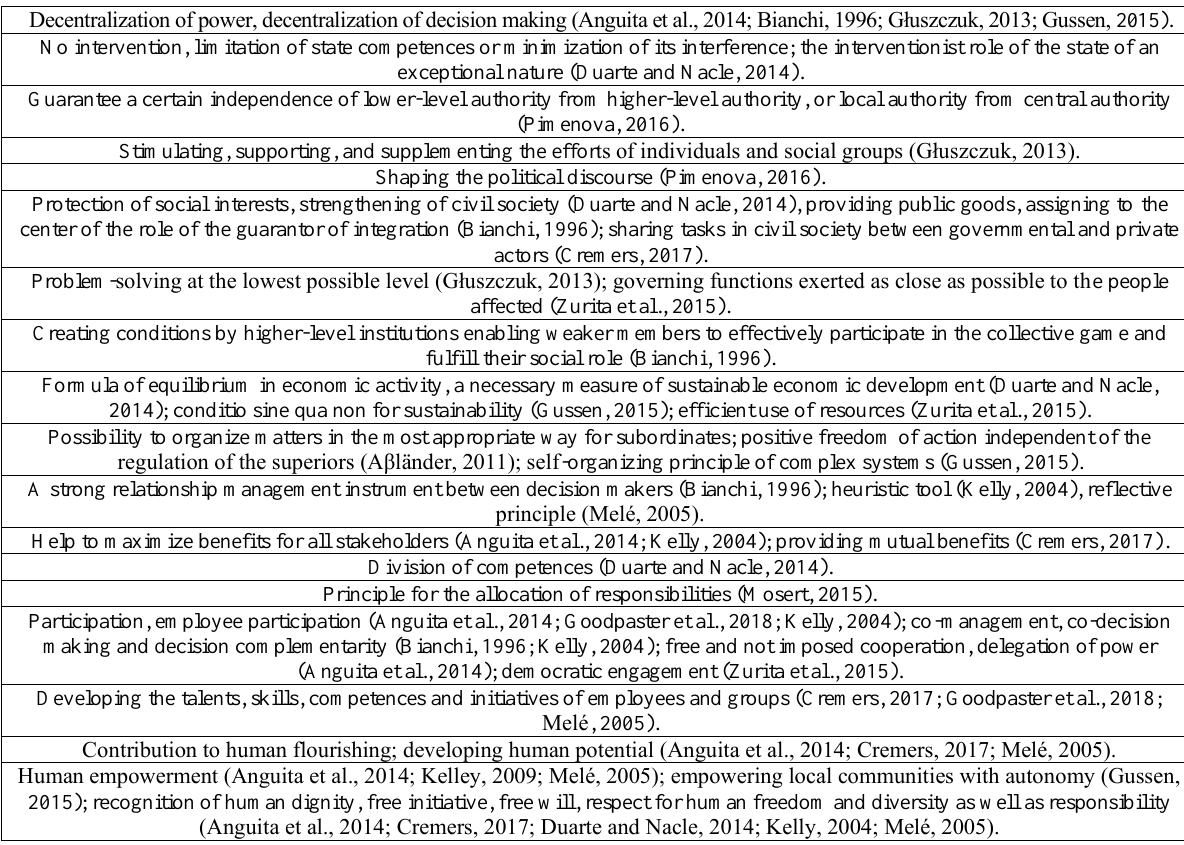
Table 1. Functional Attributes of the Subsidiarity